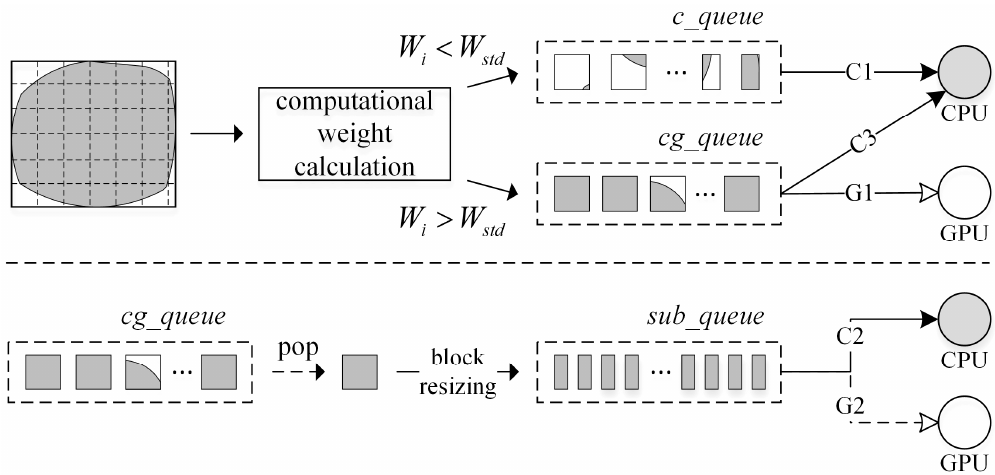
Figure 7. Illustration of the Heterogeneous Dynamic Scheduler based on the Greedy policy (HDSG) scheduling strategy.